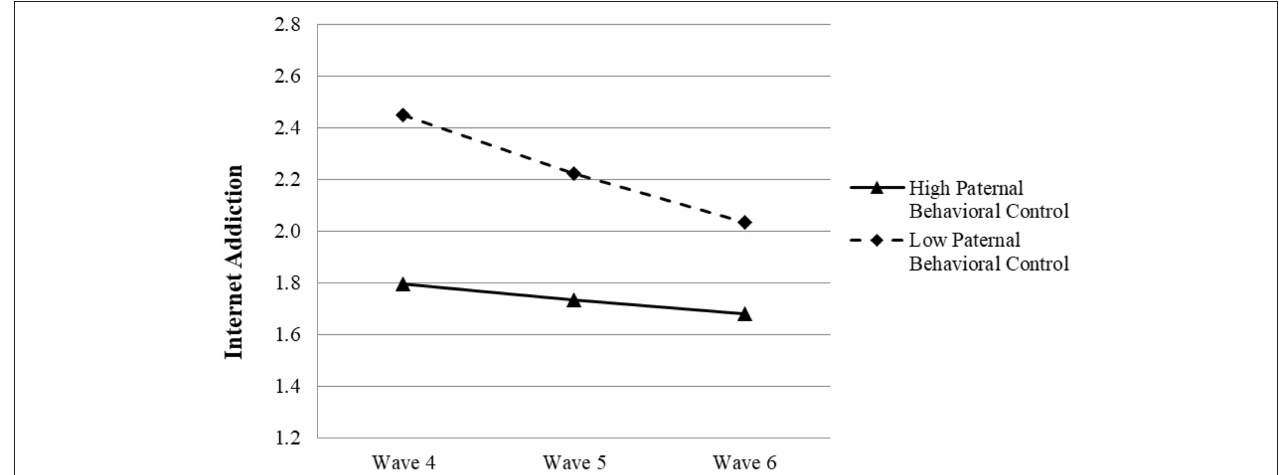
FIGURE 2 | Growth trajectories of adolescent Internet addiction as a function of paternal behavioral control. The figures were plotted based on Model 4a shown in Table 6 . High level indicates 1SD higher than the mean value; low level indicates 1SD lower than the mean value.